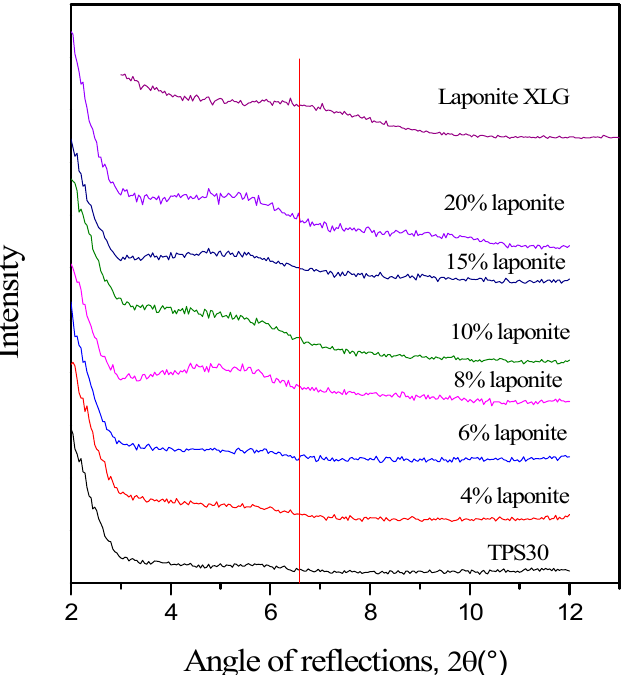
Figure 3. X-ray diffractograms of TP30, Laponite XLG, and TPS30/laponite nanocomposites. The red line marks the maximum of the laponite diffraction peak indicated in the literature around 6.6°